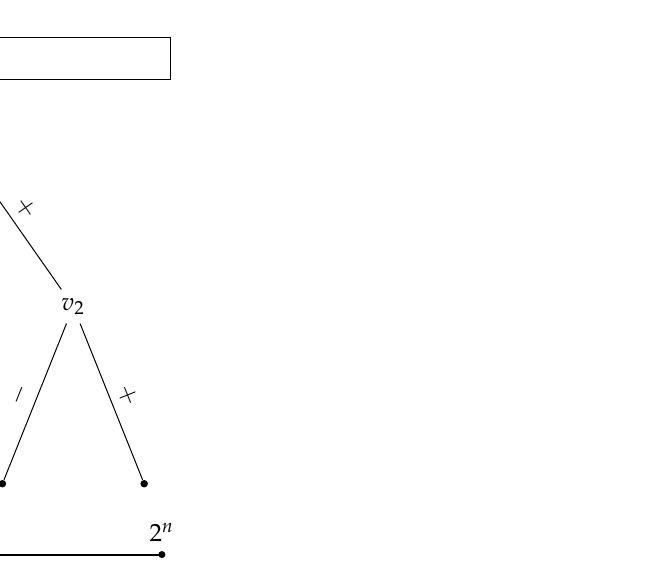
Figure 3. Geometric binary tree ( m = 2) presentation of a combinatorial problem. Numbers on the bottom imply the domain.